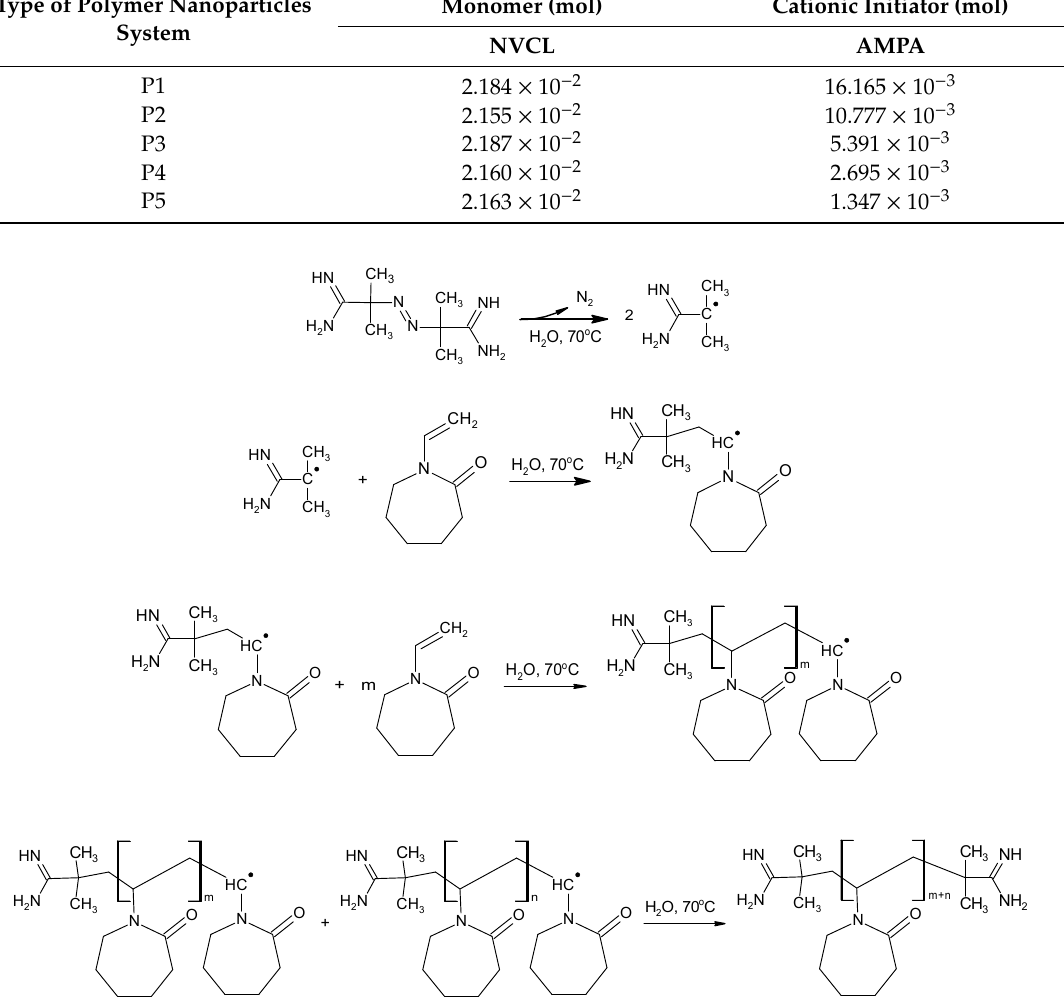
Figure 1. The basic steps of synthesis of PNVCL by polymerization of N -vinylcaprolactam (NVCL) aqueous solution in the presence of 2,2’-azobis(2-methylpropionamidine) dihydrochloride (AMPA) initiator.